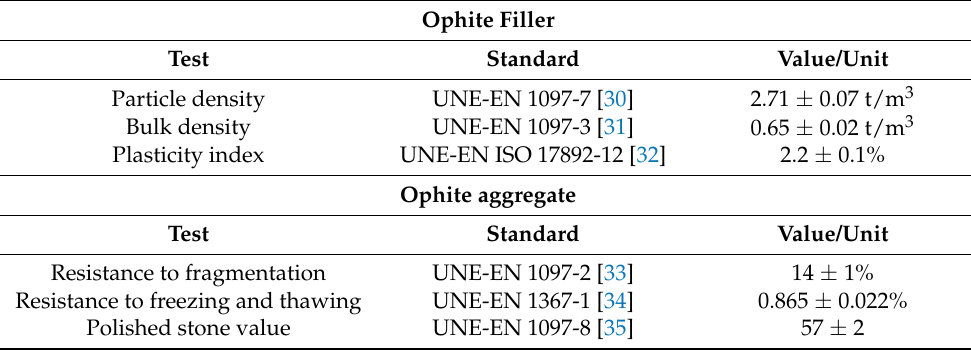
Table 2. Physical and mechanical properties of ophite aggregate and